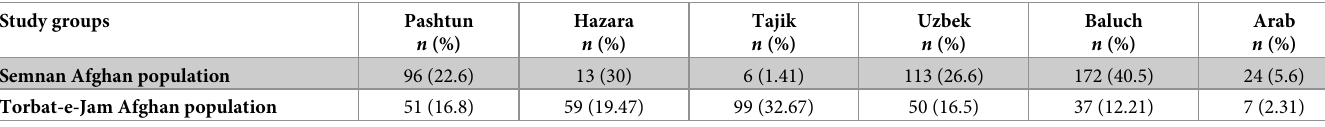
Table 2. Main ethnic groups among Afghan study groups. Study